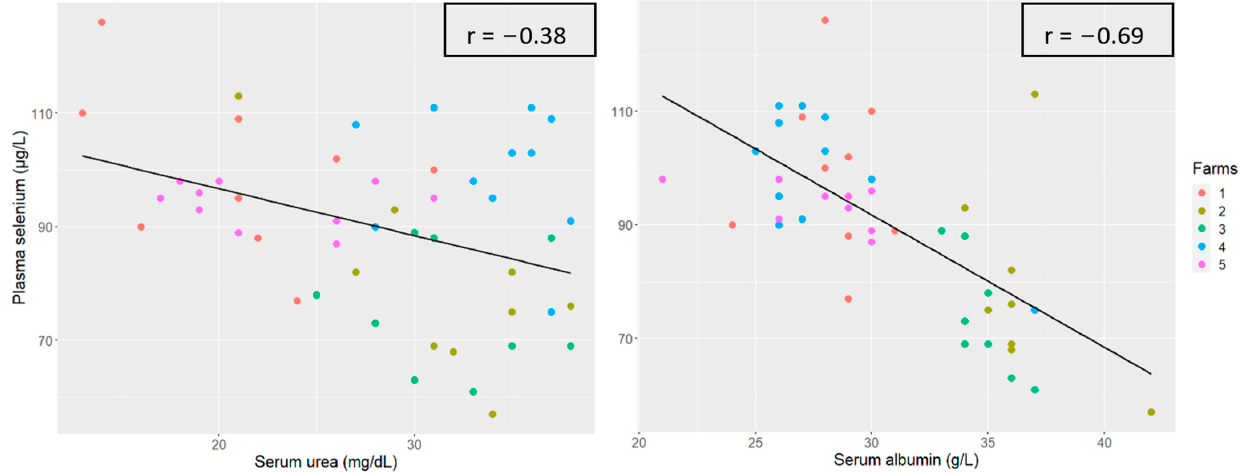
Figure 5. Scatter plot and correlation of plasma selenium concentration vs. serum urea concentration ( left ) and serum albumin concentration ( right ).